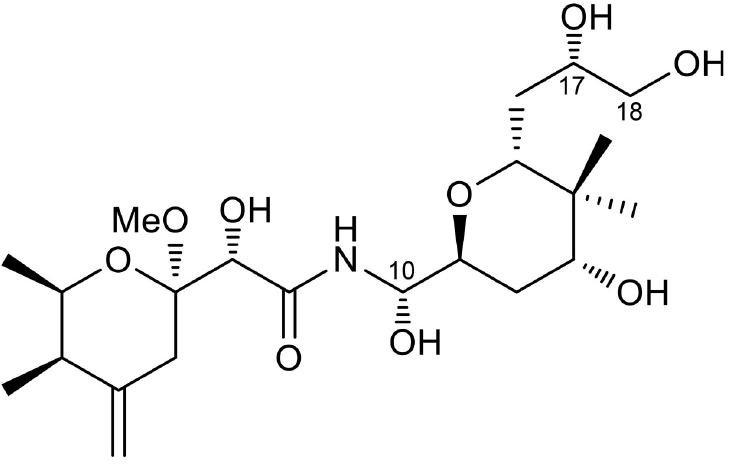
Fig 1. Chemical structure of